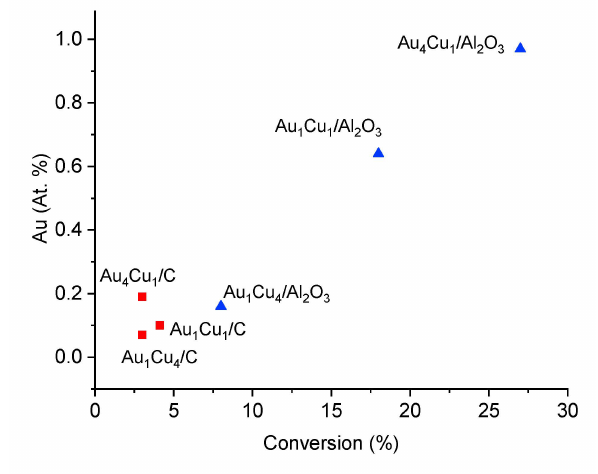
Figure 11. Influence of gold surface exposure on the conversion of VA after 1